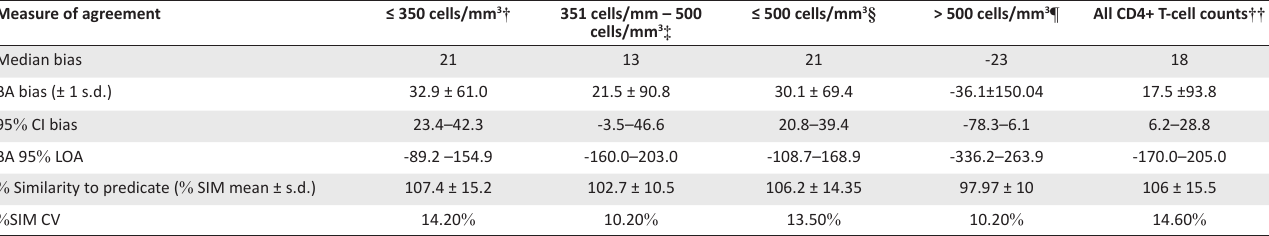
TABLE 3: Comparison of PIMA TM analysers versus National Health Laboratory Services as categorised by CD4+ T-cell counts. Measure of agreement